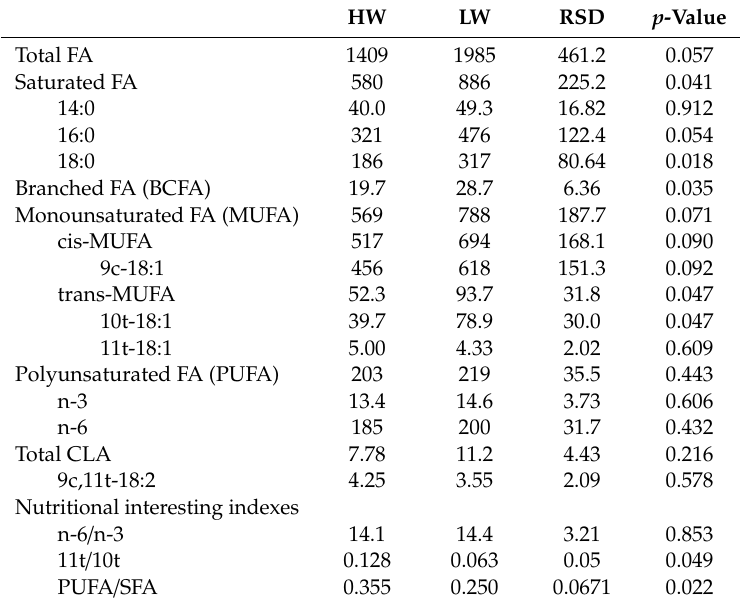
Table 6. Fatty acid (FA) profile (mg / 100 g fresh matter) of meat ( M. longisimus thoracis ) from fattening in lambs born with high (HW) or low weight (LW).